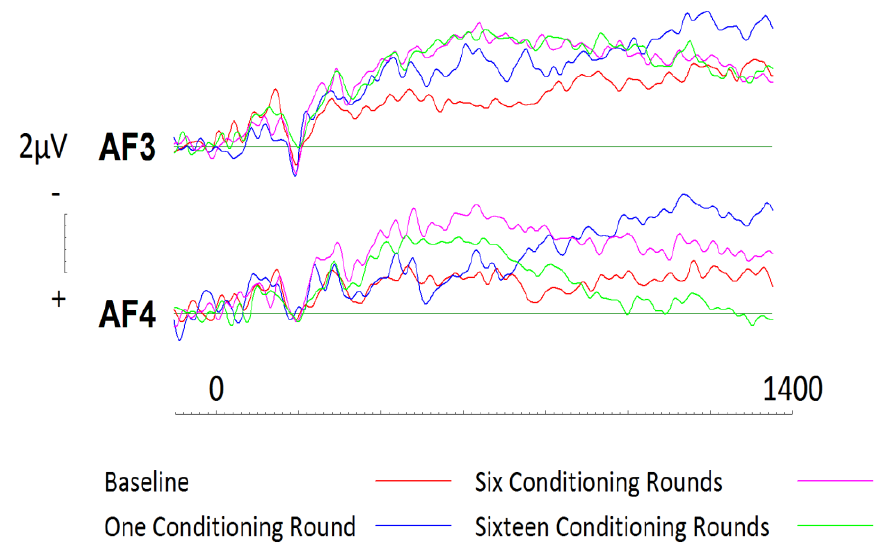
Figure 5. ERPs generated during each conditioning round for liked brands across frontal electrode sites AF3 and AF4. Gradual changes between each session are evident across both electrode sites as brands were conditioned more negatively however, these changes were not significant.